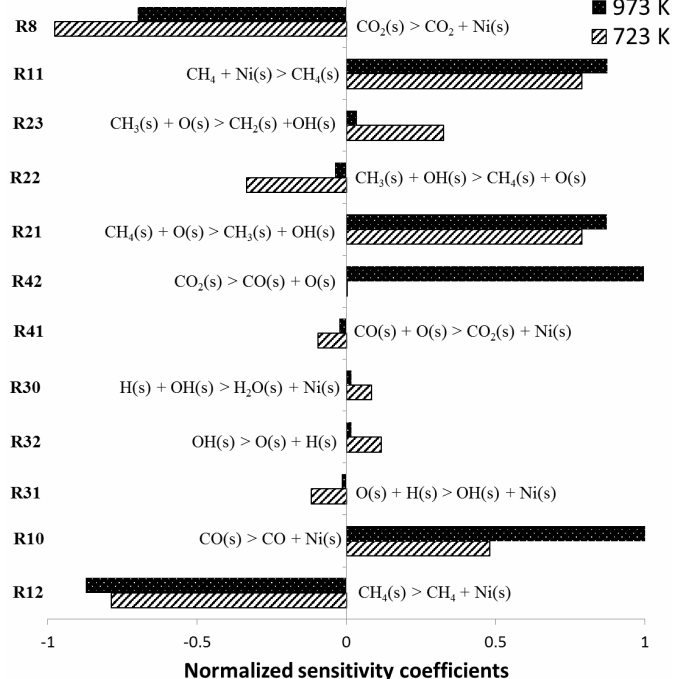
Figure 6. Sensitivity analysis of CO gas-phase concentration for Catalytic Partial Oxidation (CPOX) reaction at 723 K and 948